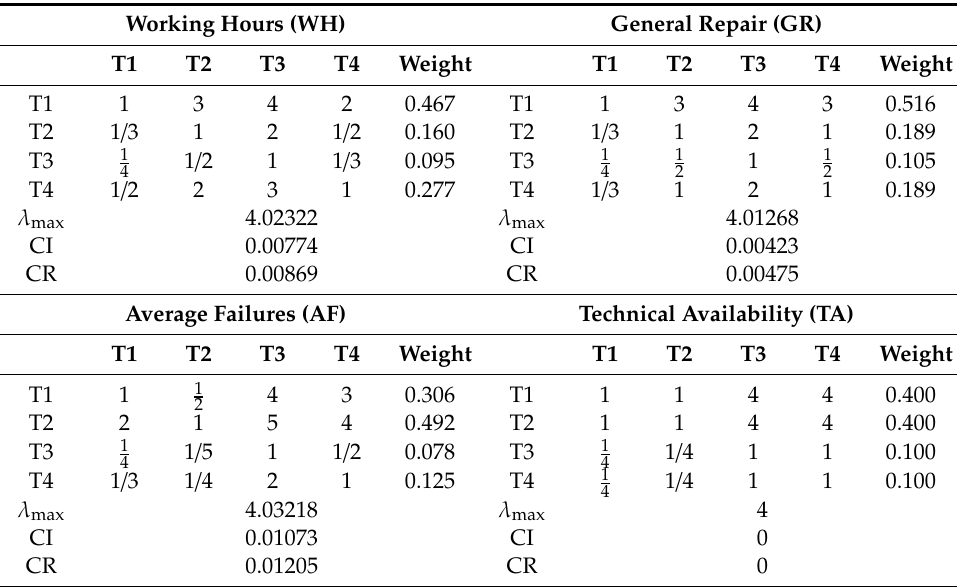
Table 11. Results of the pair-wise comparison of exploitation sub-criteria: Working hours (WH), general repair (GR), average failures (AF), technical availability (TA).